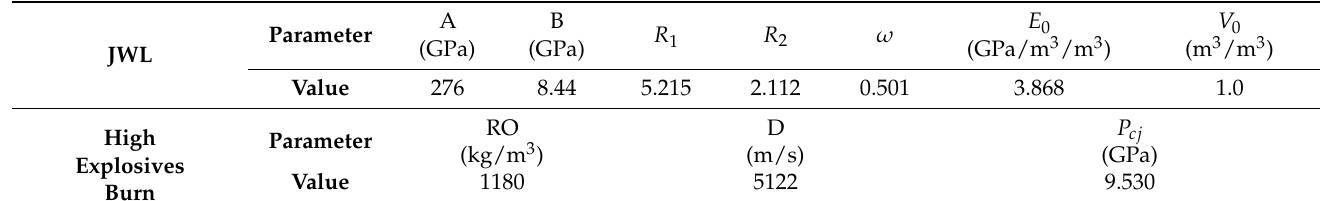
Table 2. Input parameters of JWL EOS and High_Explosive_Burn model.